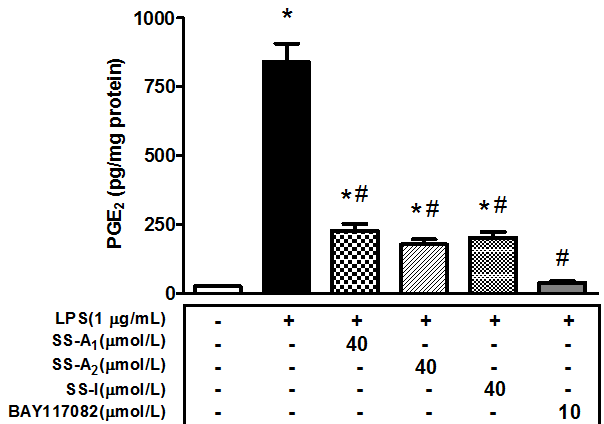
Figure 2. Soyasaponins blunt the release of inflammatory marker PGE 2 in macrophages similarly as an inhibitor of NF-kB. Cells were pre-treated with the NF-kB inhibitor (BAY117082, 10 m mol/L) or soyasaponins (A 1 , A 2 and I, 40 m mol/L) for 30 min and then stimulated with LPS (1 m g/mL) for 16 h as indicated. PGE 2 in the media was quantified with enzyme immunoassays. Results are presented as means 6 SD of 3 independent experiments. *: P , 0.05 vs. control. # : P , 0.05 vs. LPS alone.